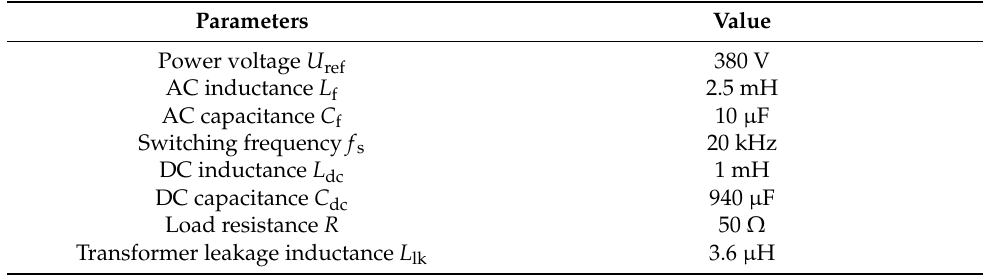
Table 4. Parameters of simulation